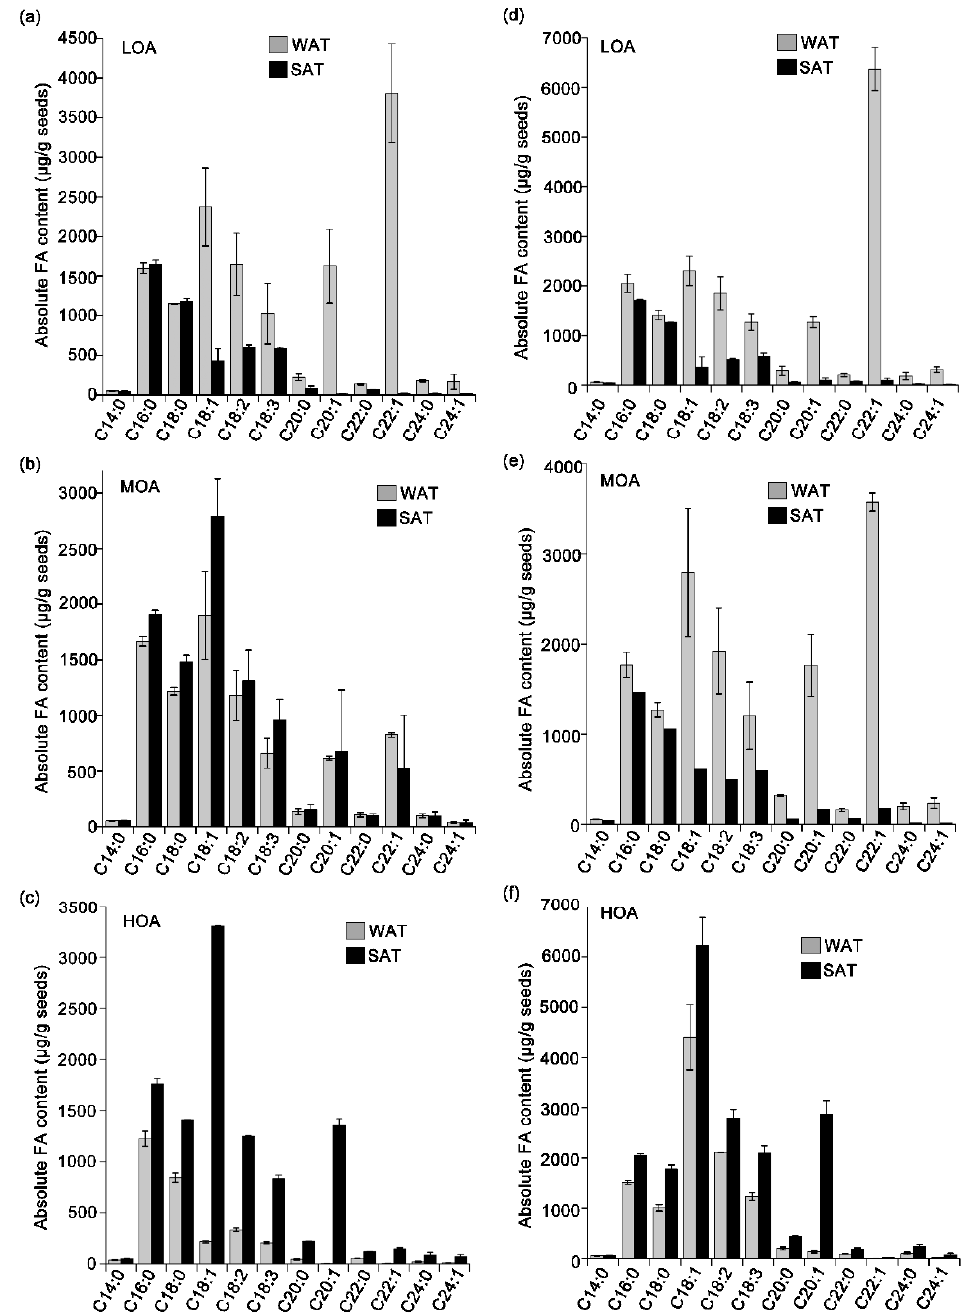
Figure 4. Comparisons of FA metabolic profiles in WAT and SAT among LOA, MOA, and HOA cultivars in the earlier period ( a – c ) and the later period ( d – f ). Values are means ± SD (n = 3 samples) in the third year.